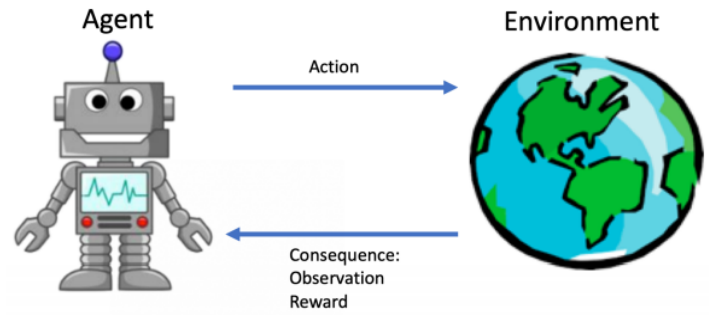
Figure 8. Agent and